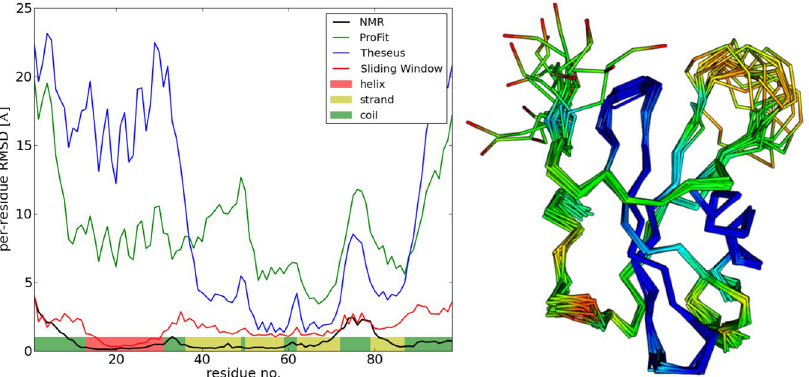
Figure 2. Disorder profile of stefin A (1DVD). NMR ensemble is compared with the same ensemble using alternative structural superposition methods – global superposition (ProFit and Theseus) and sliding window superposition. Predicted secondary structure elements are also highlighted. Visualisation of an NMR ensemble and FRAGFOLD predictions of 1DVD (stefin A). The original NMR ensemble deposited in the PDB was split, so that all of the conformations are overlaid onto each other. FRAGFOLD-IDP prediction is represented here by a spectrum of colours, where blue represents the most rigid predicted residues, followed by green and yellow. Orange and red represent the most disordered regions according to FRAGFOLD-IDP